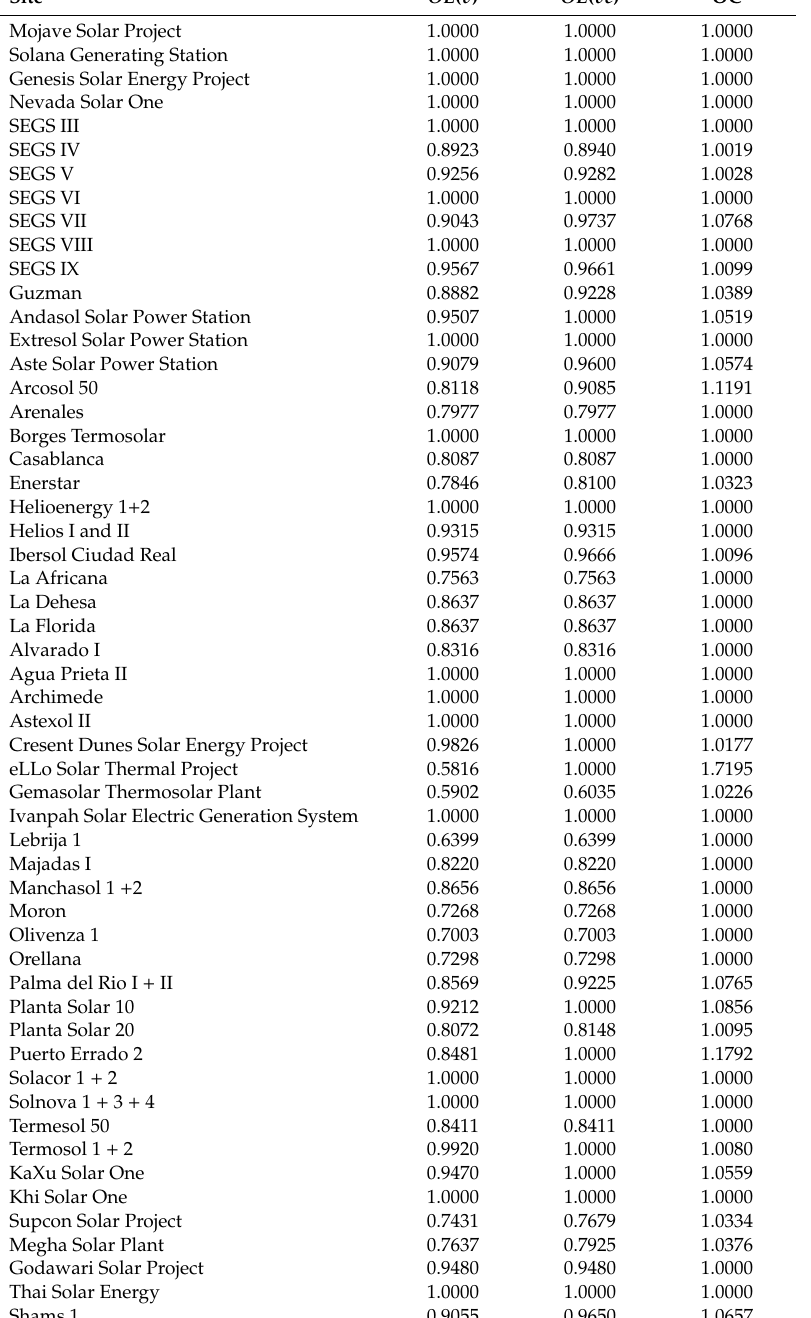
Table 6. Operational e ffi ciency and output-based